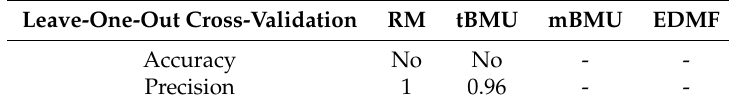
Table 9. Accuracy and precision established using a leave-one-out cross-validation approach. For mBMU and EMDF, the entire model class was rejected and, thus, no updated parameter values could be validated. For tBMU, absence of accuracy indicates that uncertainties were